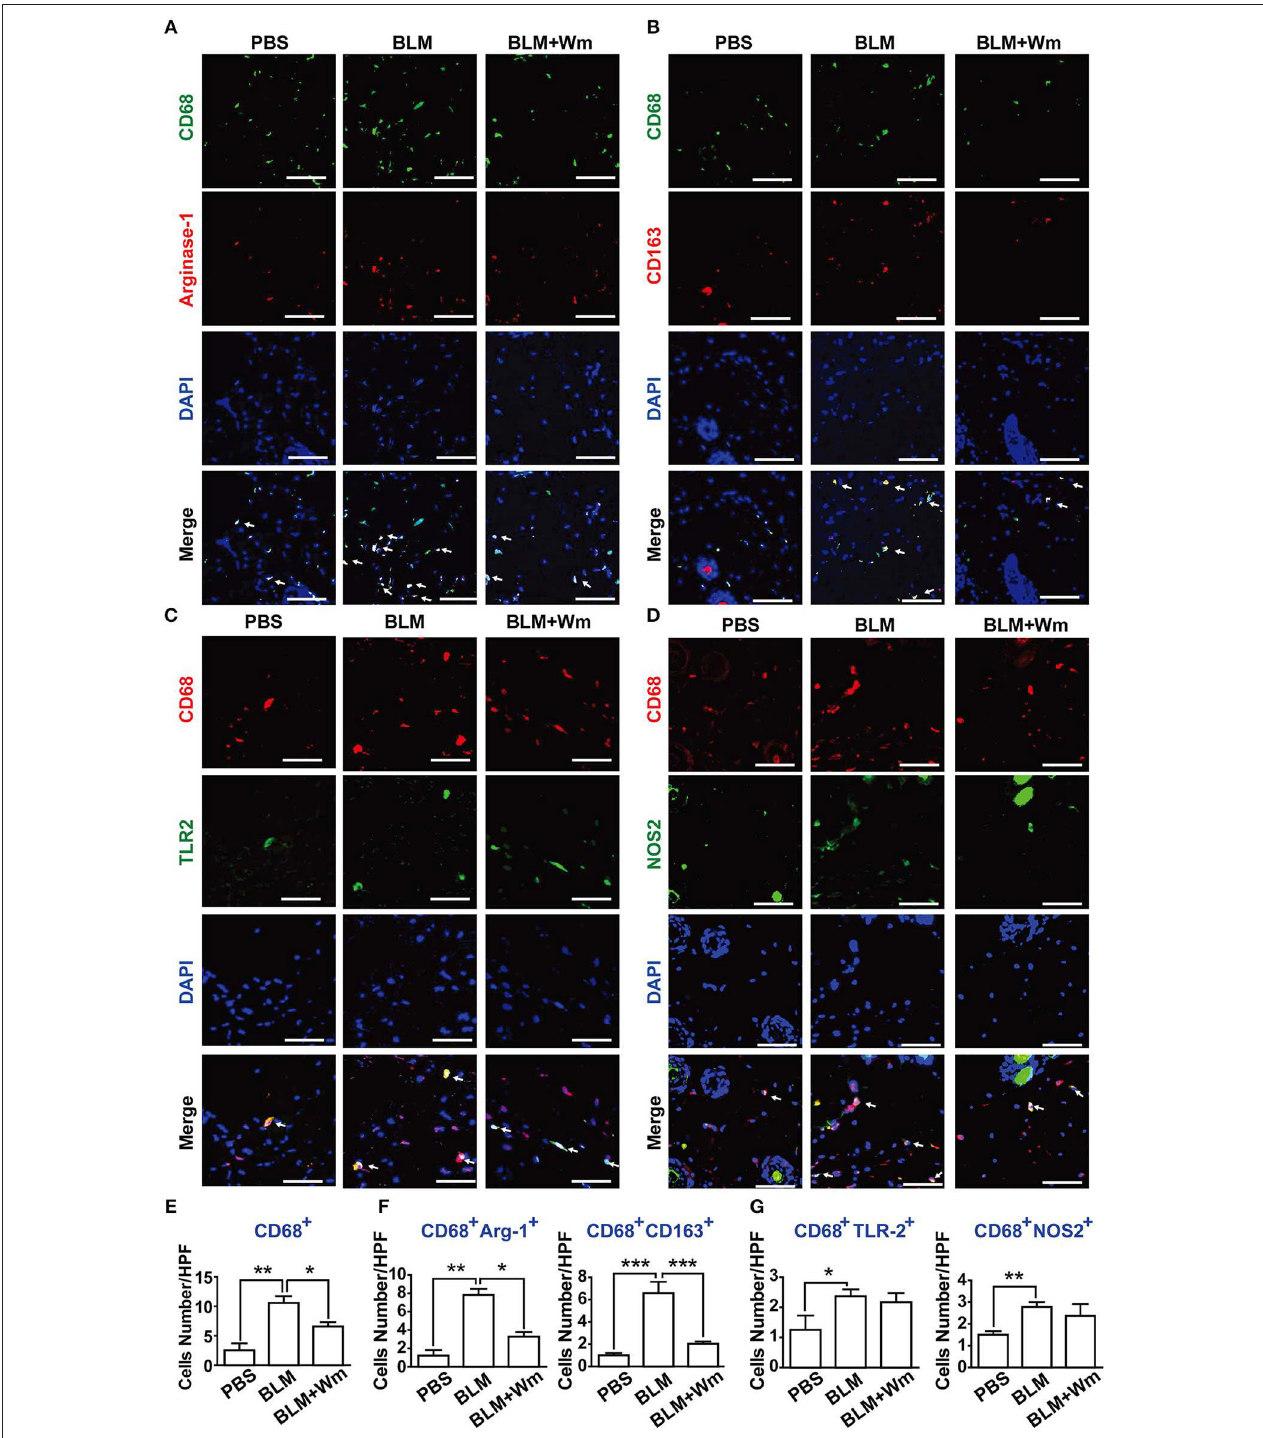
FIGURE 4 | Effects of WKYMVm treatment on macrophage polarization and inflammation in scleroderma. The BLM-induced scleroderma mice were treated with or without Wm for 3 weeks. The mock-treated (PBS) and scleroderma (BLM or BLM + Wm) skin specimens were stained with anti-CD68 antibody together with anti-Arginase-1 (A) , anti-CD163 (B) , anti-TLR2 (C) , or NOS2 (D) antibodies. Nuclei was stained with DAPI, and overlaid images are shown. Scale bar = 50 µ m. The numbers of CD68 + macrophages (E) , M2 type macrophages ( F : CD68 + Arginse-1 + and CD68 + CD163 + cells), M1 type macrophages ( G : CD68 + TLR2 + and CD68 + NOS2 + cells) were counted under high-power field. Data represent mean ± SD ( n = 8 per group). * p < 0.05, ** p < 0.01, *** p < 0.001.